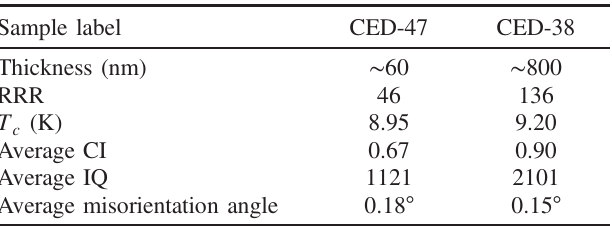
TABLE II. Crystal quality being measured by EBSD. It shows crystal quality progressively evolves by thickening a Nb film.